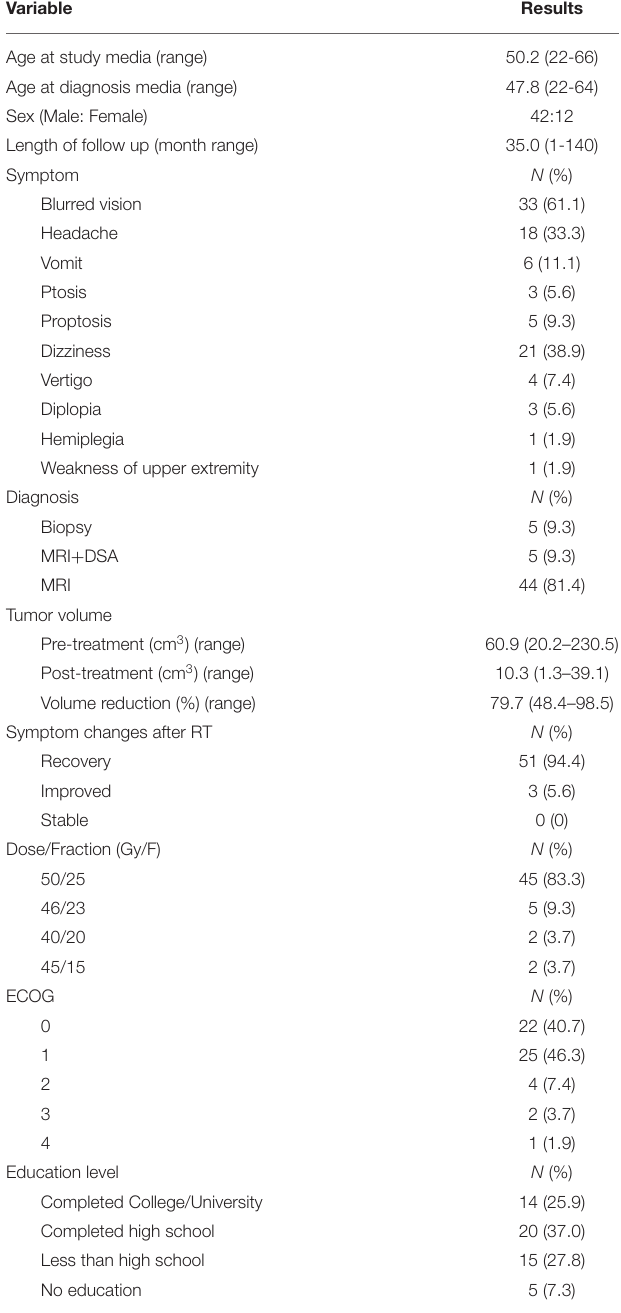
TABLE 1 | Baseline demographic and clinical factors of patients with large and giant CSHs. Variable